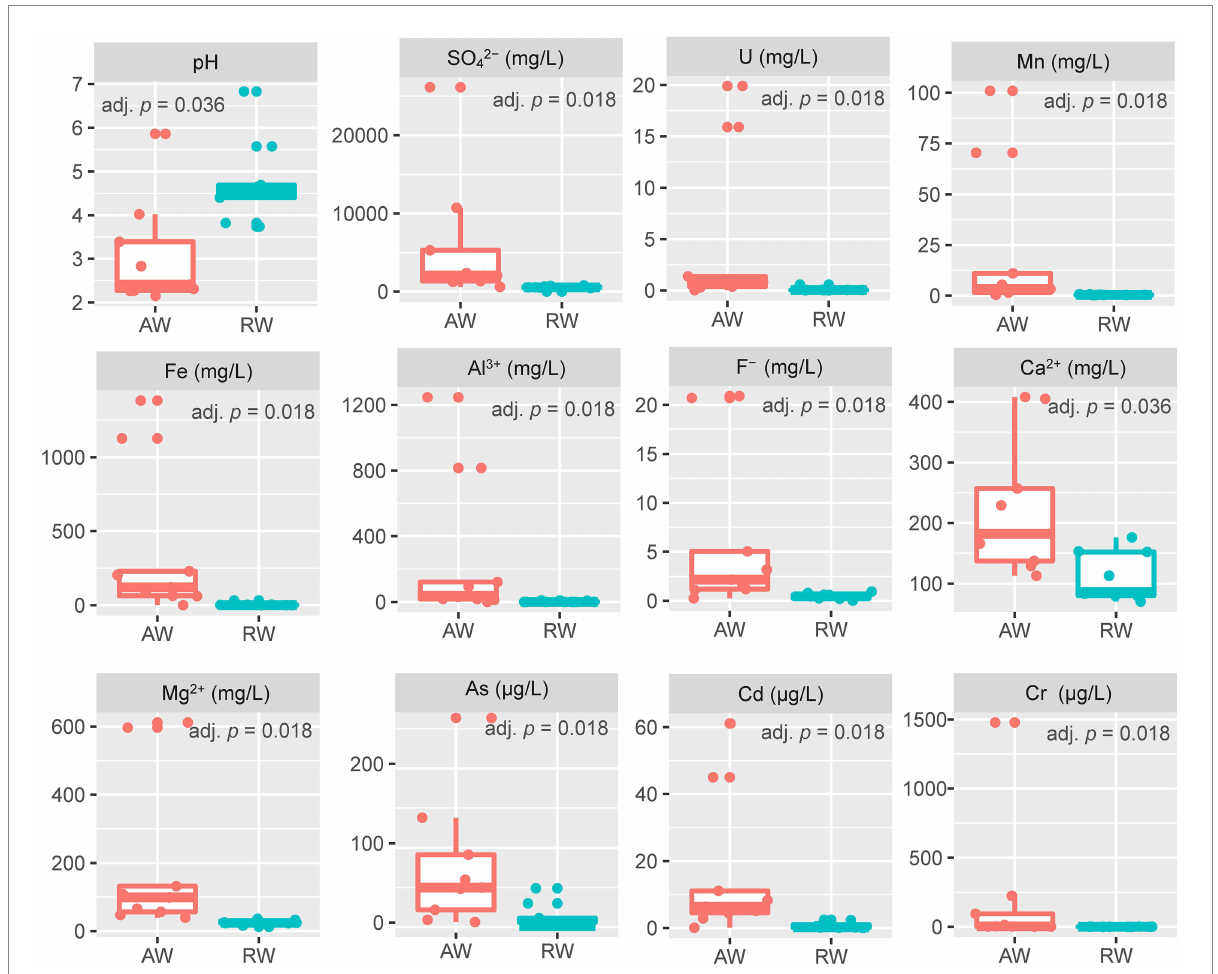
FIGURE 2 Boxplot of environmental factors between the two sample types (AW and RW). For the values of each environmental factor between the AW and RW samples, we used the non-parametric Wilcoxon signed-rank test to evaluate their differences and the corresponding Benjamini and Hochberg (BH) adjusted p -value (adj. p ) was